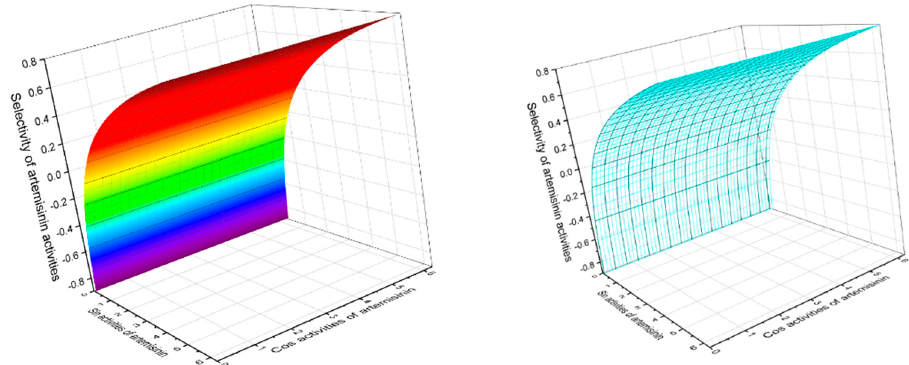
Figure 13. The 3D graph shows the predicted and calculated pharmacological activities of artemisinin ( 86 ), which was found in 1979 in the extract of the Chinese herb Qinghaosu ( Artemisia annua ). According to PASS data, this endoperoxide demonstrated 16 different activities, with 5 activities having a found confidence of more than 90 percent. Antiprotozoal selective activity of artemisinin against obligate intracellular protozoan parasites belonging to the genera Plasmodium (99.5%), Toxoplasma (93%), Leishmania (92.3%), and Coccidia (78%) is the main pharmacological activity. In addition, artemisinin demonstrated strong anti-schistosomal activity (91.1%) against Schistosoma mansoni , a human blood fluke parasite. Additionally, artemisinin shows antifungal activity against an opportunistic pathogenic yeast Candida (91.5%) and Cryptococcus (85.3%), although anticancer activity is found at 80%.